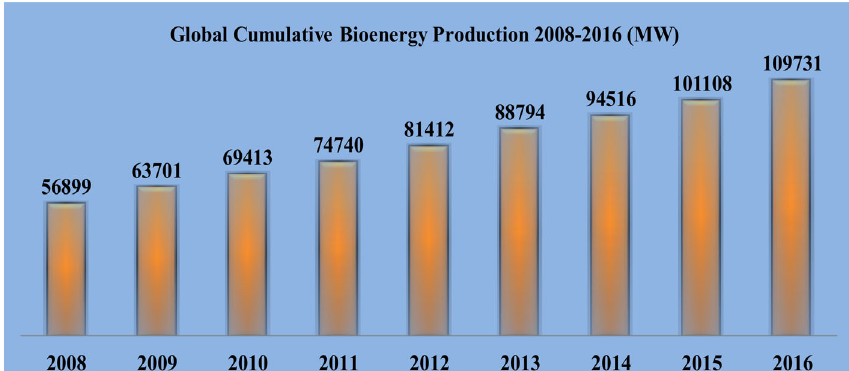
Fig. 6 Global Cumulative Bio-Energy Generation in 2008-2016 [8,